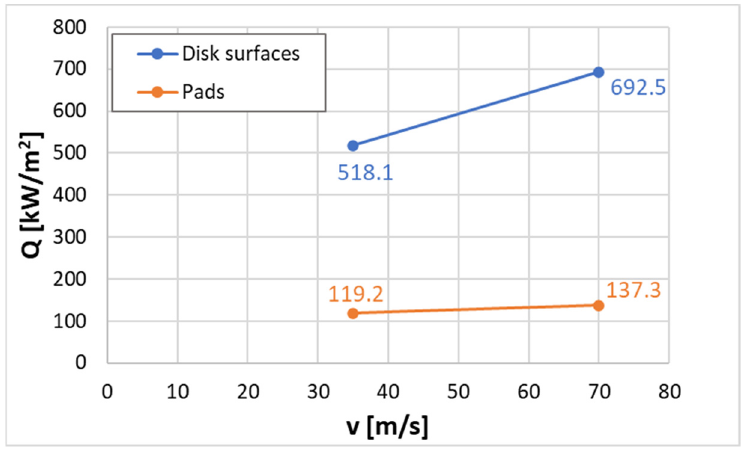
Figure 18. Heat flux removed from the main components at different car speeds—all coupled heat transfer mechanisms.